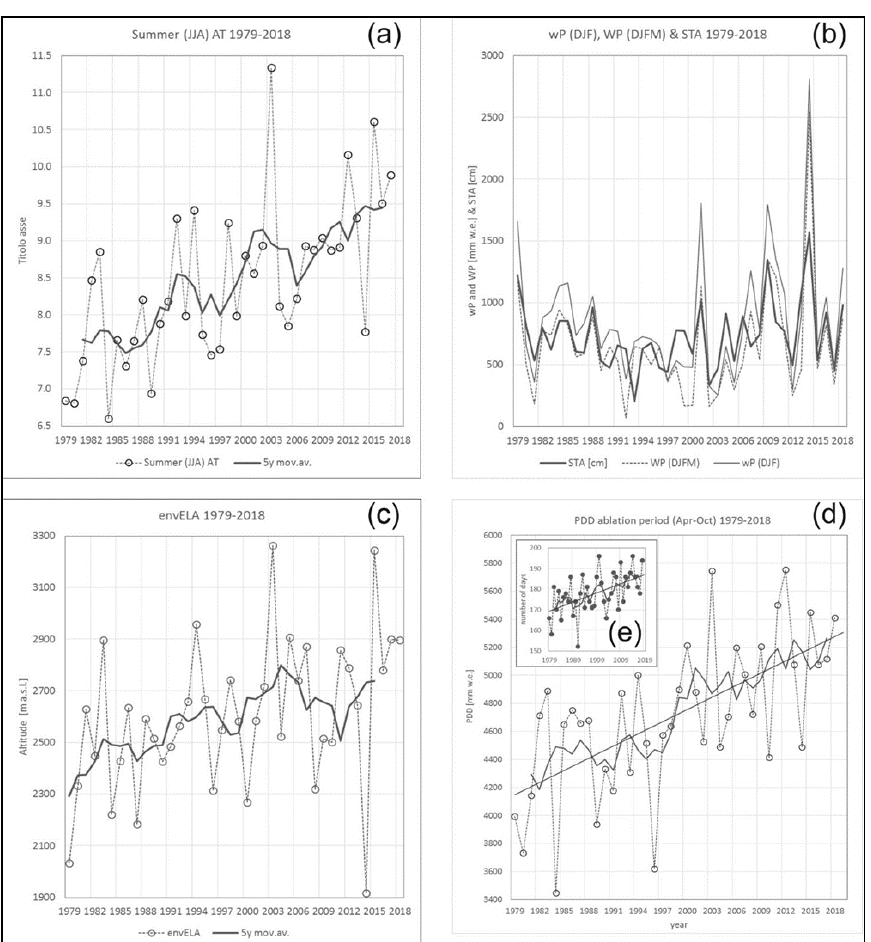
Figure 7. Climatic data observed in the 40 years period 1979–2018: ( a ) summer air temperature (JJA); ( b ) winter precipitation (djf; wP) and extended winter precipitation (djfm; WP) and snow total accumulation (STA); ( c ) environmental ELA [15,17]; ( d ) number of positive degree days and PDD sum.